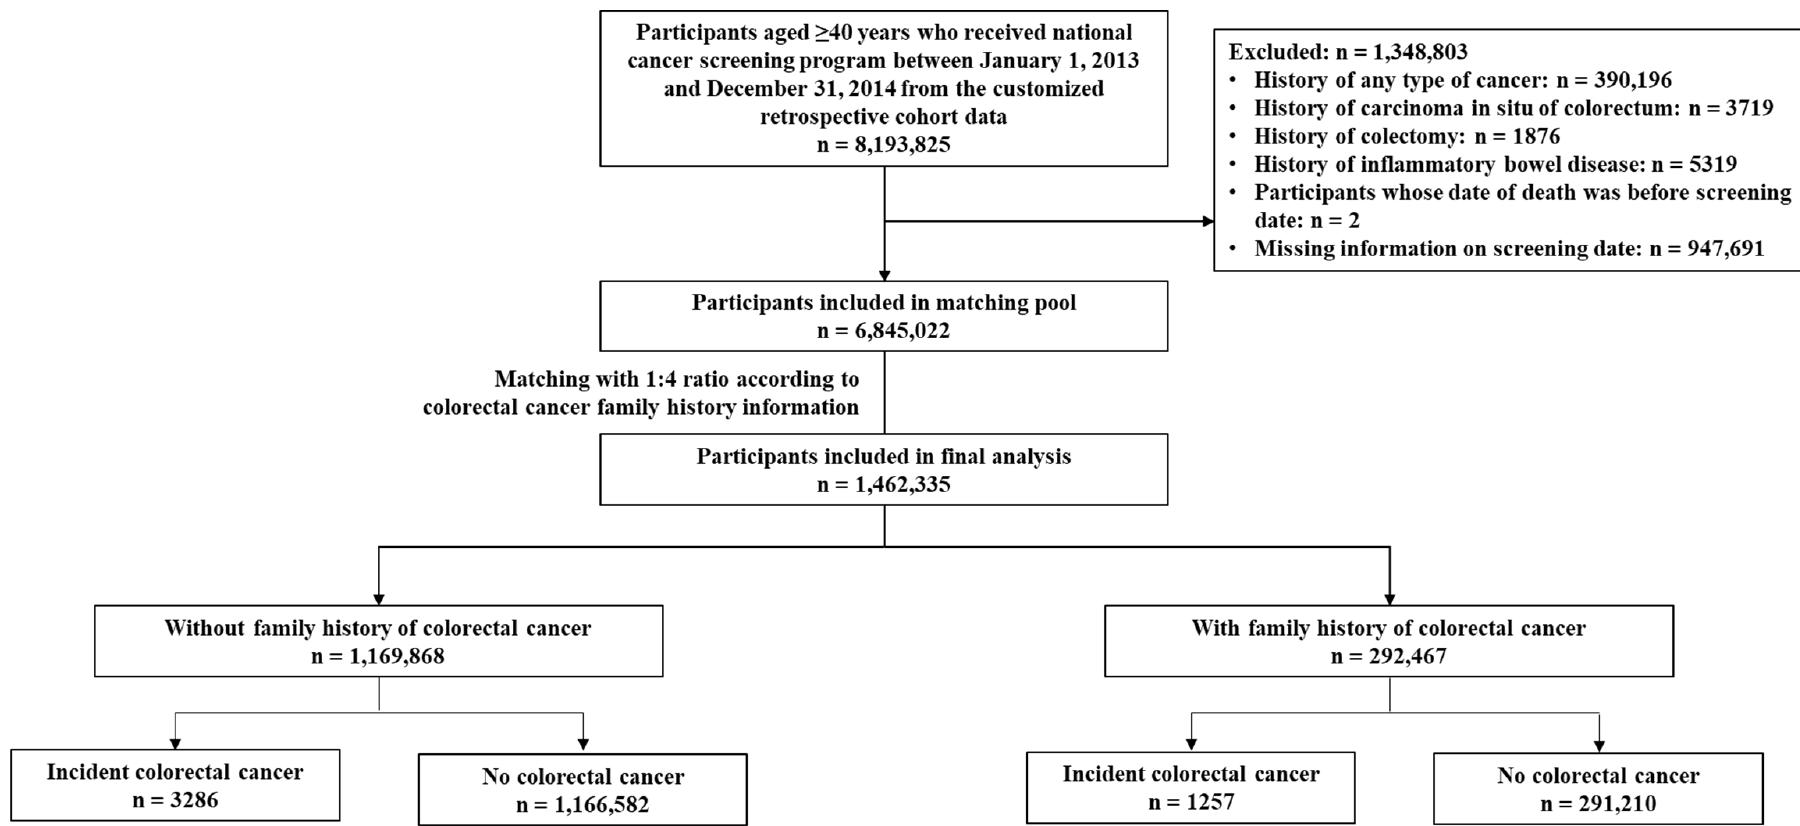
Figure 1. Flowchart of the study population.